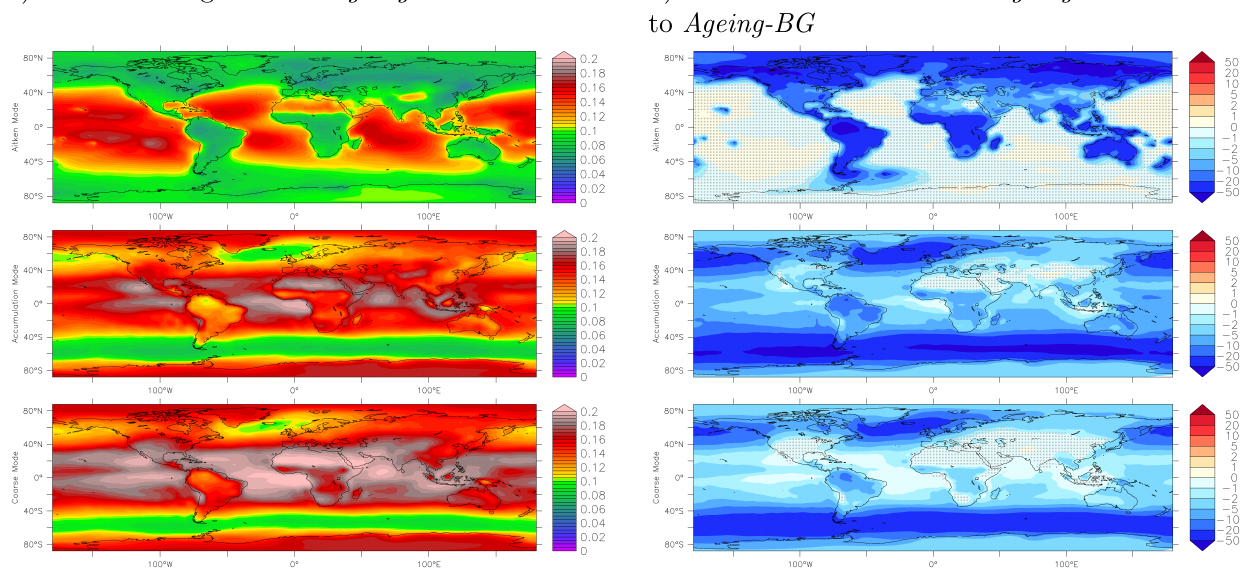
Fig. 5. Annual averages of the organic κ for the Ageing-BG simulation at the height of the planetary boundary layer (PBL) (a) . The individual panels represent the three larger hydrophilic aerosol modes: Aitken, accumulation and coarse mode (from upper to lower panels). (b) displays the relative difference of the Ageing-LO simulation to the Ageing-BG scenario (“ Ageing-LO ” − “ Ageing-BG ”)/“ Ageing-BG ” · 100 in % for the three modes. The dotted regions are those in which the differences are of low statistical